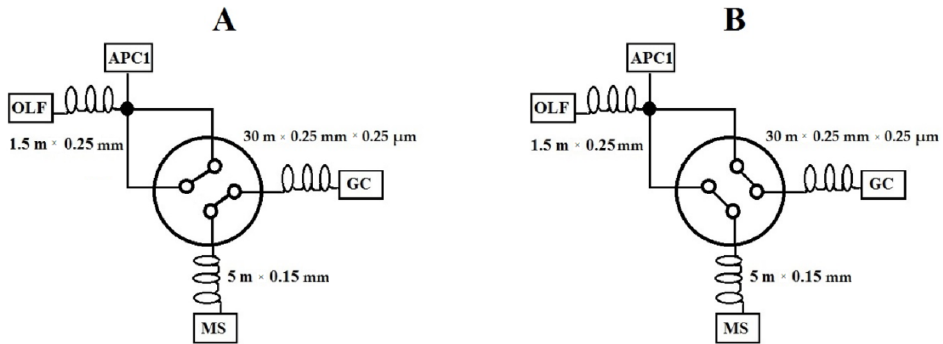
Figure 2. Diagram of a two-position four-way valve in positions ( A ) and ( B ), with the marked chromatographic column and applied